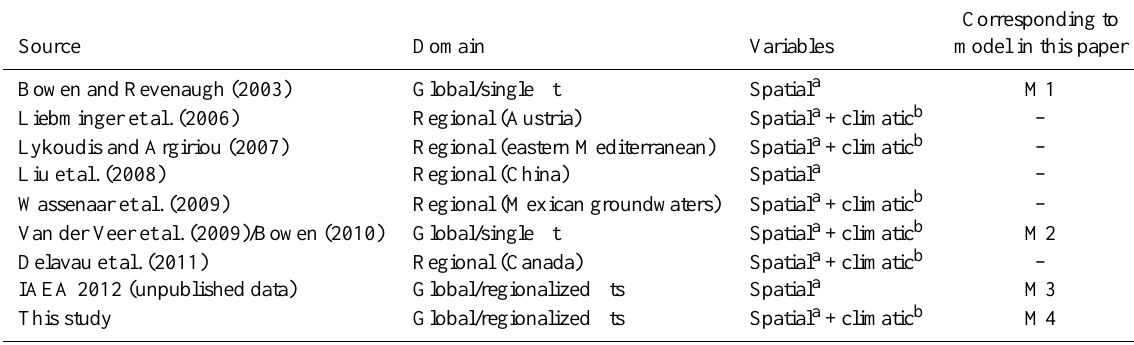
Table 1. Examples of global and regional water isotope models and type of predictive spatial and climatic variables used for the isotopic composition of precipitation and ground water.